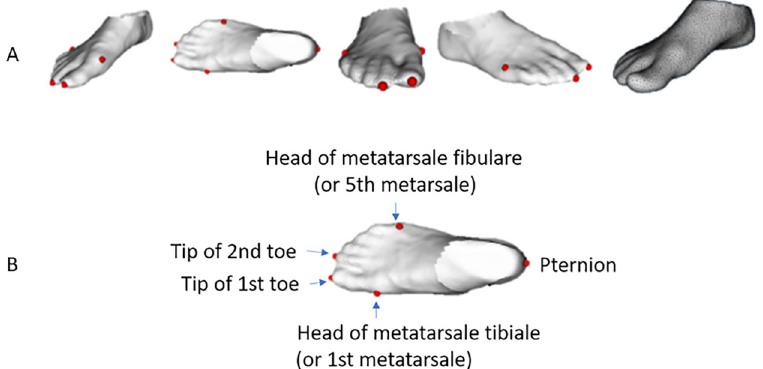
Fig 4. Foot landmarks. (A) Foot landmarks used in the registration of the database and foot template topology (the last image). (B) Names of the five foot landmarks.